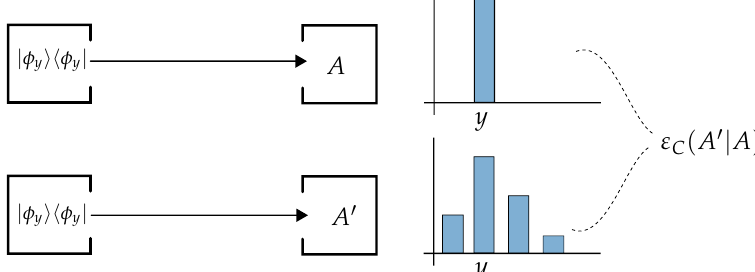
Figure 4. For the calibration error ε C ( A (cid:48) | A ) , the input state is constrained to the eigenstates of A ,